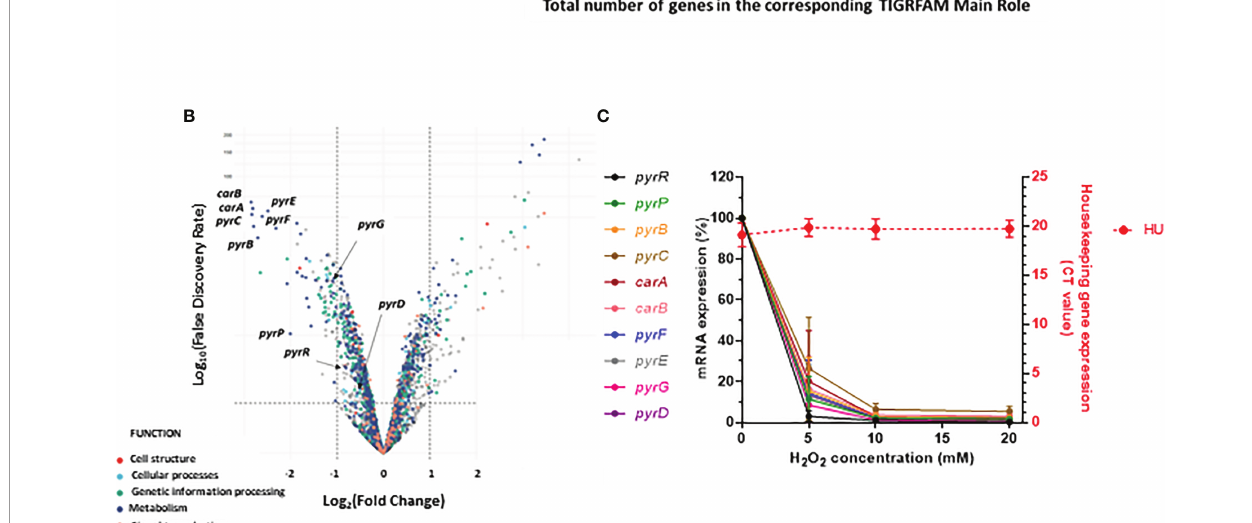
FIGURE 2 | Downregulation of genes involved in pyrimidine metabolism after H 2 O 2 exposure. (A) Pyramid plot displaying signi fi cant affected S. aureus genes in the presence of H 2 O 2 . From the total number of genes present in the TIGRAM main role category, the signi fi cant affected gene categories were selected, based on TIGRFAM category “ Sub-Role ” (FDR <0.05 and fold change ≤ -2 or ≥ 2). Gene categories upregulated or downregulated upon H 2 O 2 exposure are indicated in red or blue, respectively. (B) Volcano plot of RNA-Seq data representing the differential gene expression analysis of S. aureus JE2 exposed or not to one hour of sublethal H 2 O 2 . The upper left panel represents genes signi fi cantly (FDR <0.05 and Fold change ≤ -2) downregulated after H 2 O 2 exposure. The upper right panel represents genes signi fi cantly (FDR <0.05 and Fold change ≥ 2) upregulated after H 2 O 2 exposure. RNA-Seq results were normalized using DESeq2 software. (C) Effect of different concentrations of H 2 O 2 on pyr genes expression. Bacteria were exposed for one hour to different concentrations of H 2 O 2 . pyr gene expression was assessed by qRT-PCR. Relative expression levels were determined by comparing cycle threshold (CT) of each gene to the CT value of the hu gene for the same cDNA preparation. Left y axe represents mRNA expression of pyr genes and right y axe shows the minimal variation of hu CT values with different H 2 O 2 concentrations (CT 20 +/- 0.3). These results represent the mean ± SD of three independent experiments (three replicates for each H 2 O 2 concentration and three replicates for each